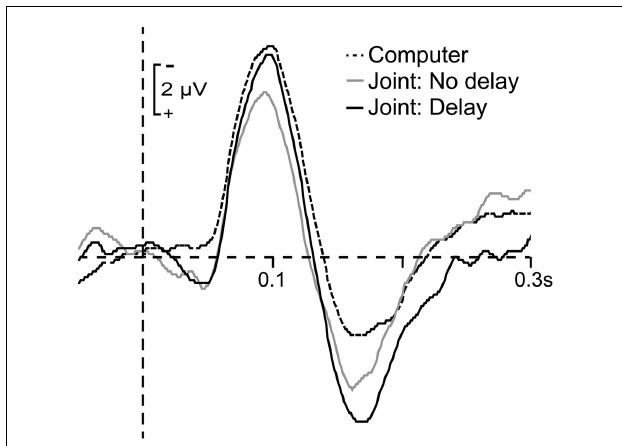
FIGURE 4 | Grand average waveforms time-locked to the onset of computer-generated tones (dashed line), jointly generated tones in no-delay trials (solid gray line), and jointly generated tones in delay trials (solid black line). ERP responses to jointly generated tones were corrected for motor activity related to button